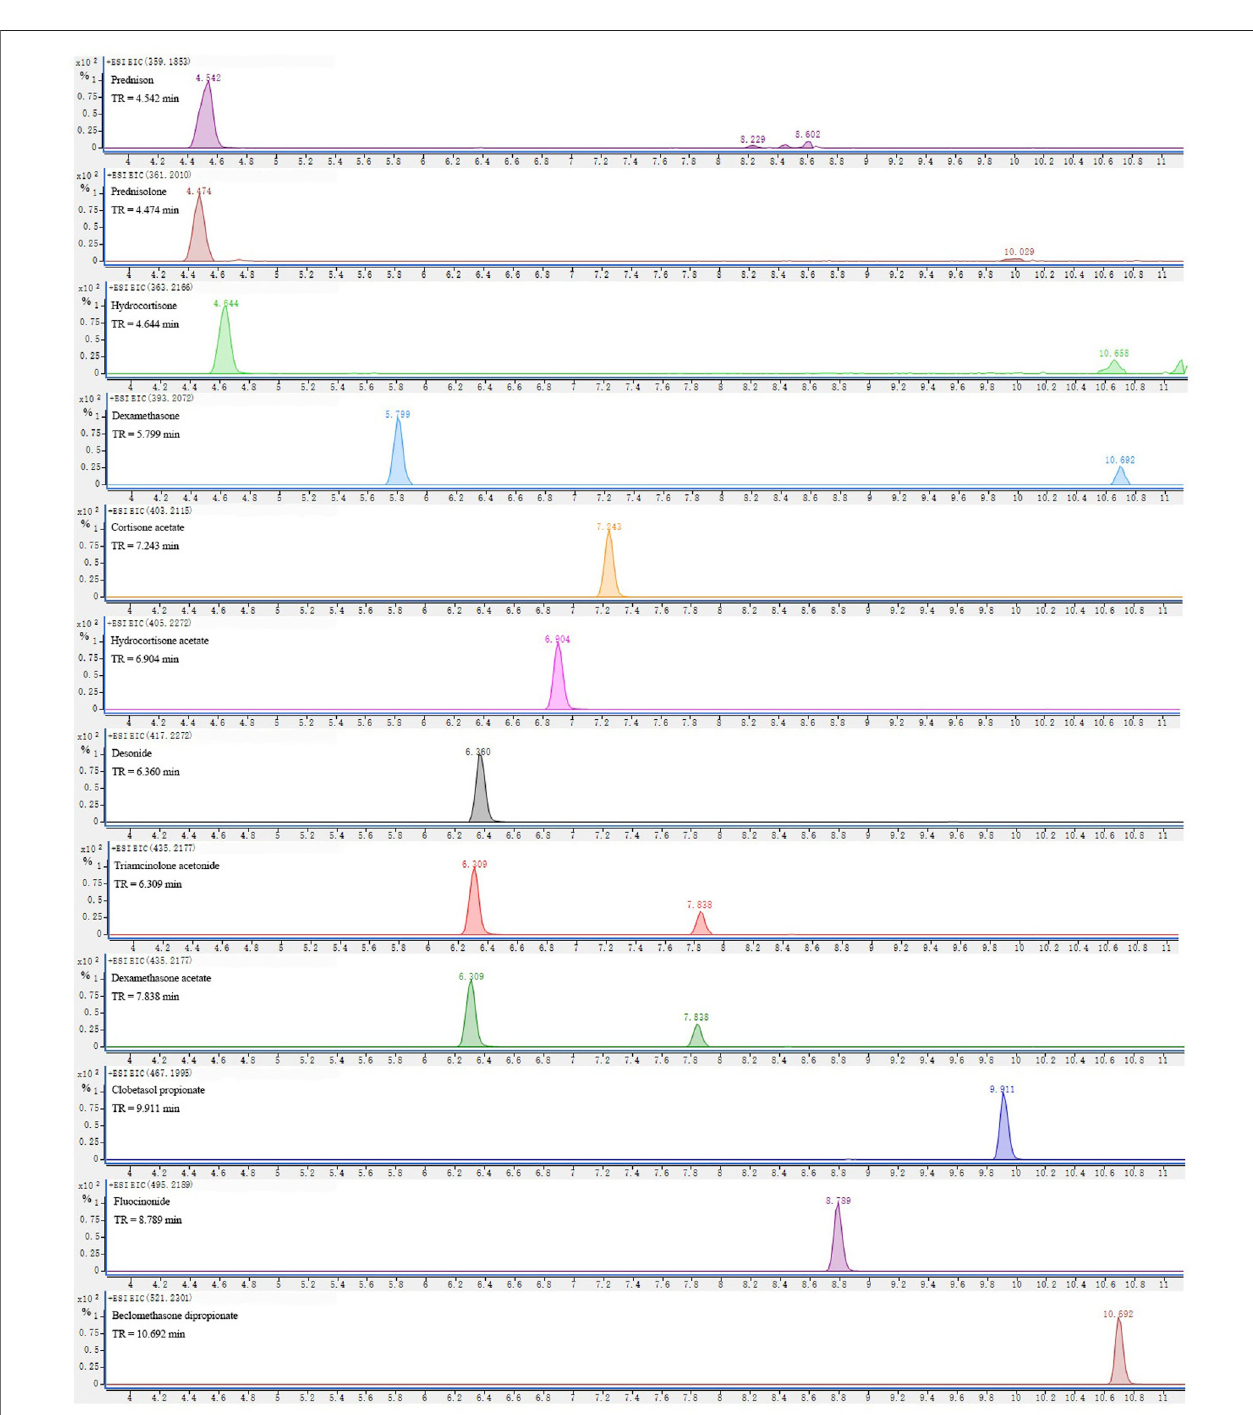
FIGURE 2 | Extracted ion chromatograms (EICs) at ± 10 ppm mass windows for [M + H] + of targeted analytes in a standard solution at 1,000 ng/ml.